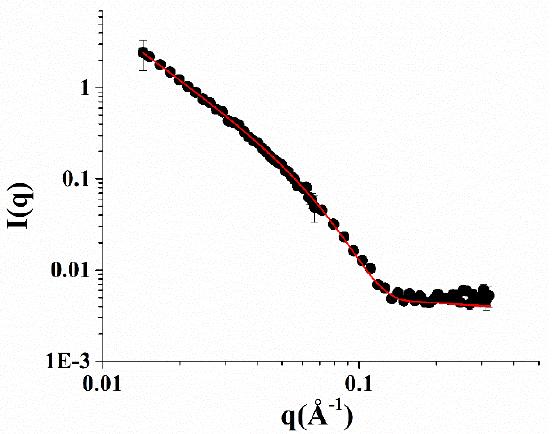
Figure 4. SANS profiles of the NOTA-OL/POPC 5:95 liposomes. Experimental data are represented as black full circles, while the best fitting curve according to a vesicles model is shown as a red line. (Ga)NOTA-OL/POPC 5:95 liposomes, incorporating the preformed (Ga)NOTA-OL